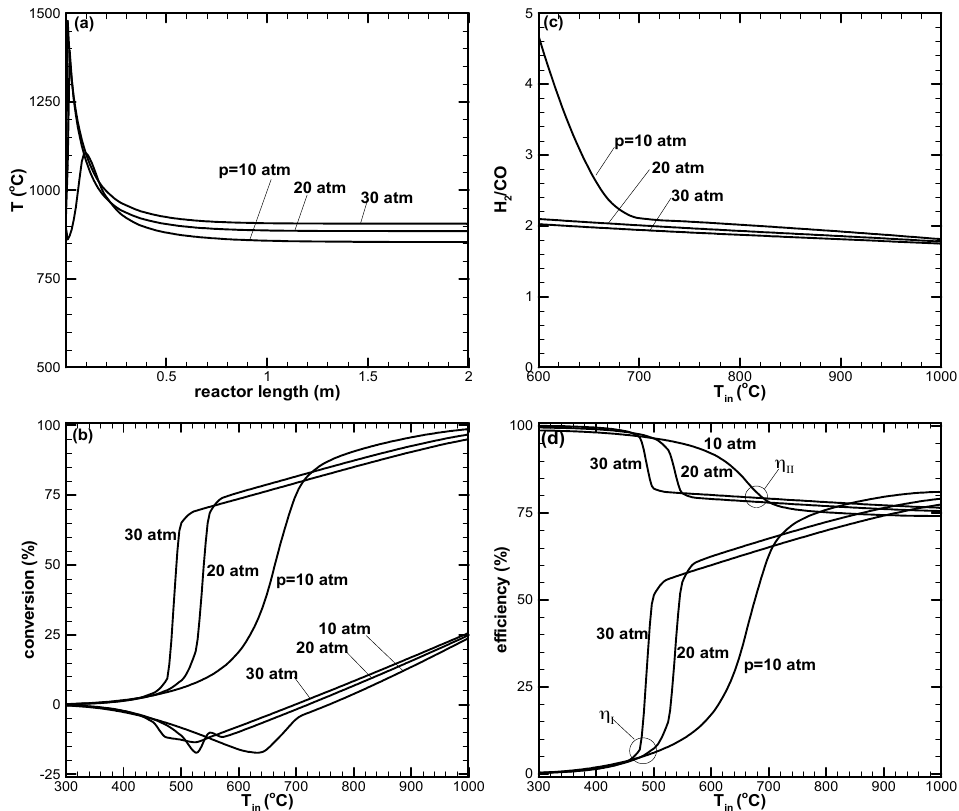
Figure 6. Effect of pressure on the TR process. Pressure is varied from 10 to 30 atm while the other parameters were kept unchanged, as listed in Table 1. ( a ) Temperature variation along reactor with T in = 900 °C; ( b ) CH 4 and CO 2 conversions; ( c ) H 2 /CO ratio; and ( d ) first- and second-law efficiencies.